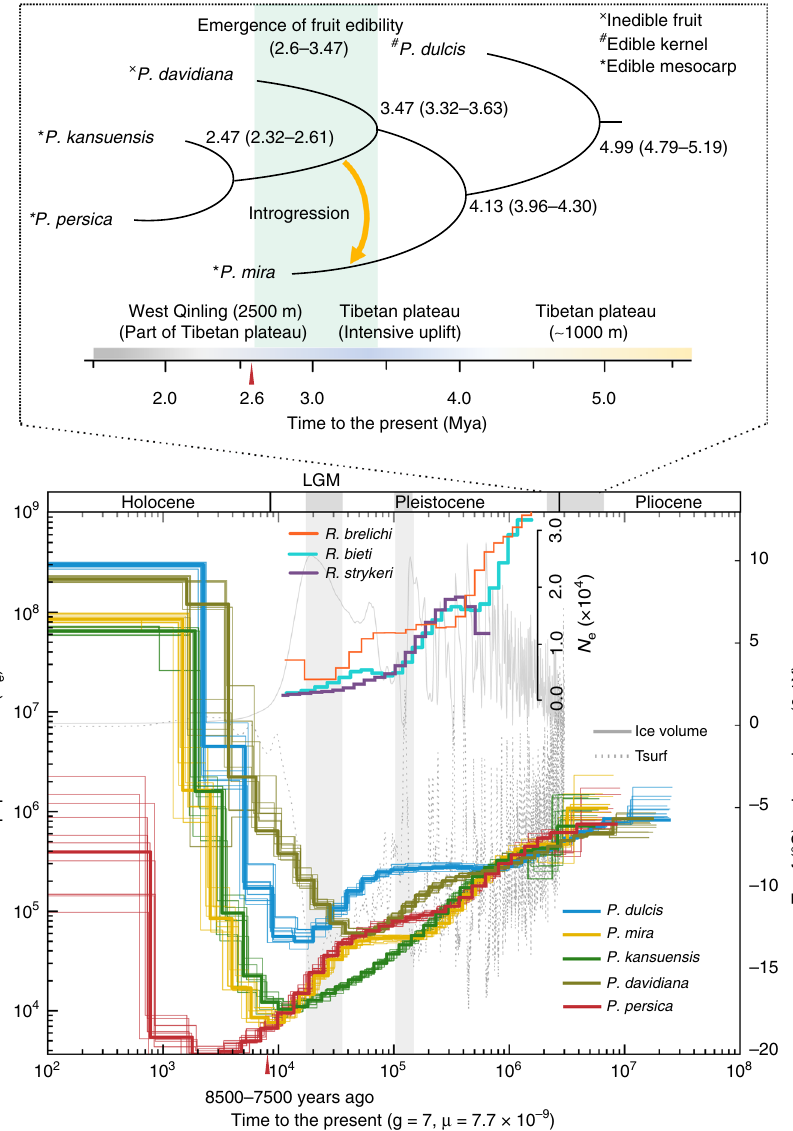
Fig. 3 Speciation and demographic history of peach species. BEAST analysis was used to estimate divergence times of P. persica , P. kansuensis , P. davidiana , P. mira , and P. dulcis , and an MSMC model was used to infer their effective population ( N e ) fl uctuations under a mutation rate μ = 7.7 × 10 – 9 per site per generation according to Xie et al. 17 . The divergence time of each species was shown in each branch, the emergence time of edible fruit in peach species (4.13 – 2.6 Mya) was showed with green shadow, and a single introgression event is indicated with an orange arrow between P. mira and the common ancestor of P. kansuensis and P. persica . Peach speciation likely was in fl uenced by uplifts of the Tibet plateau. In the demographic diagram, the gray solid and dotted lines show, respectively, the ice volume and the global surface air temperature (Tsurf), as reconstructed using benthic oxygen isotope ( δ O 18 ) stack record data 70 , and the N e trajectories of three monkey species ( Rhinopithecus. brelichi , R. bieti , and R. strykeri ) from Zhou et al. 28 are inserted in the diagram. Two red triangles indicate peach endocarp fossil evidence from 2.6 Mya and 8500 – 7500 years ago, respectively 4,5 . LGM, Last Glacial